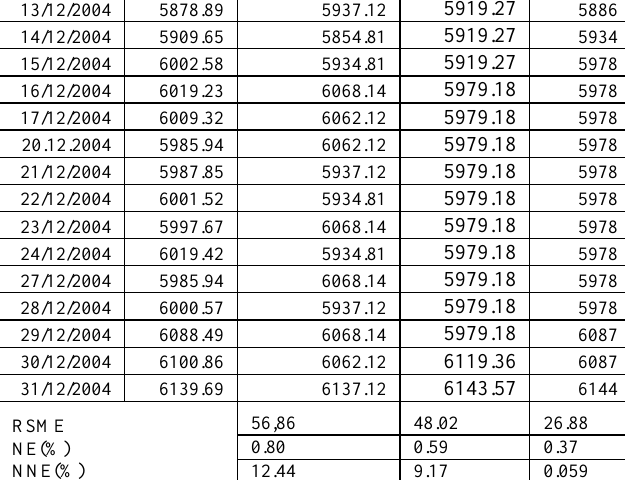
Table 6. Shown the detailed results of the proposed method and the preceding